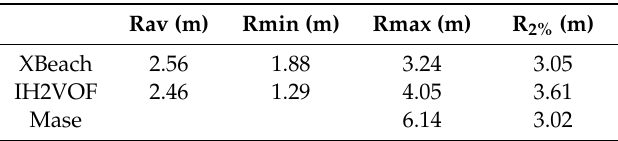
Figure 8. Run-up time series predicted using XBeach and IH2VOF for simplified representative hydro-morphologic conditions in case I.NO, designed for the non-occurrence of overtopping. Table 3. Average, minimum, maximum, and two percent wave run-up predicted using XBeach and IH2VOF in case I.NO. Maximum and two percent wave run-up predicted using Mase formulas in case